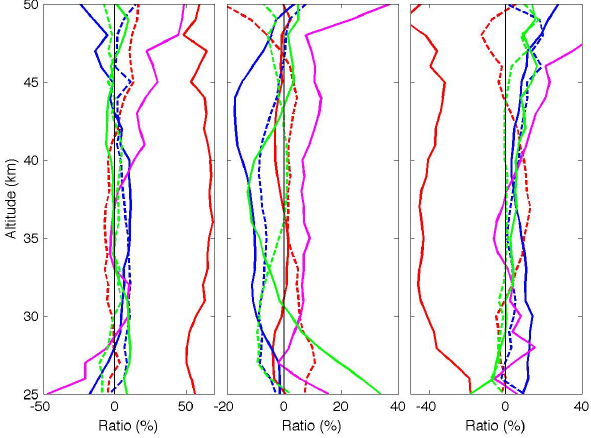
Fig. 29. Correlations of the monthly GOMOS NO 3 median den- sities with the monthly median temperatures (from ECMWF) as a function of altitude. Left: 30 ◦ S–50 ◦ S, Middle: 10 ◦ S–10 ◦ N, Right: 30 ◦ N–50 ◦ N. Line identifications: DJF: blue, MAM: red, JJA: green, SON: